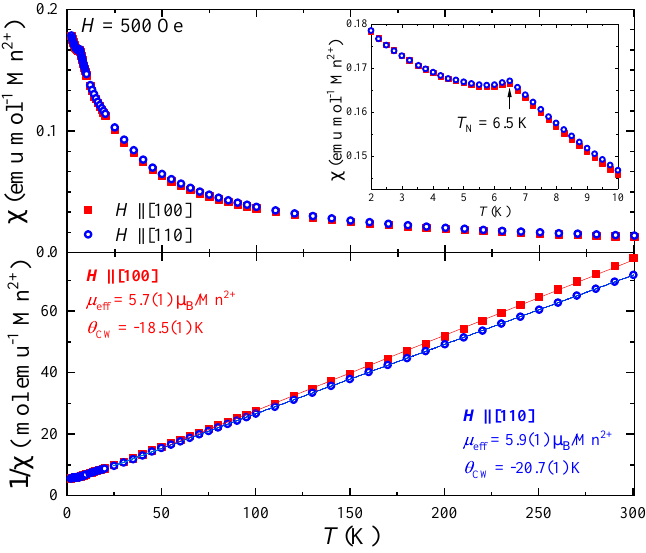
Figure 9. ( top ) Temperature dependent magnetic susceptibility, χ ( T ) , for a Mn 3 Al 2 Ge 3 O 12 crystal fragment isolated from the MAGG_C2 boule, for H (cid:107) [ 100 ] (shown in red) and H (cid:107) [ 110 ] (blue), in the temperature range 2 − 300 K and an applied magnetic field of 500 Oe. The inset shows an ordering temperature of T N = 6.5 K. ( bottom ) The temperature dependence of χ − 1 ( T ) and the fit in the temperature range 50 − 300 K using the Curie-Weiss